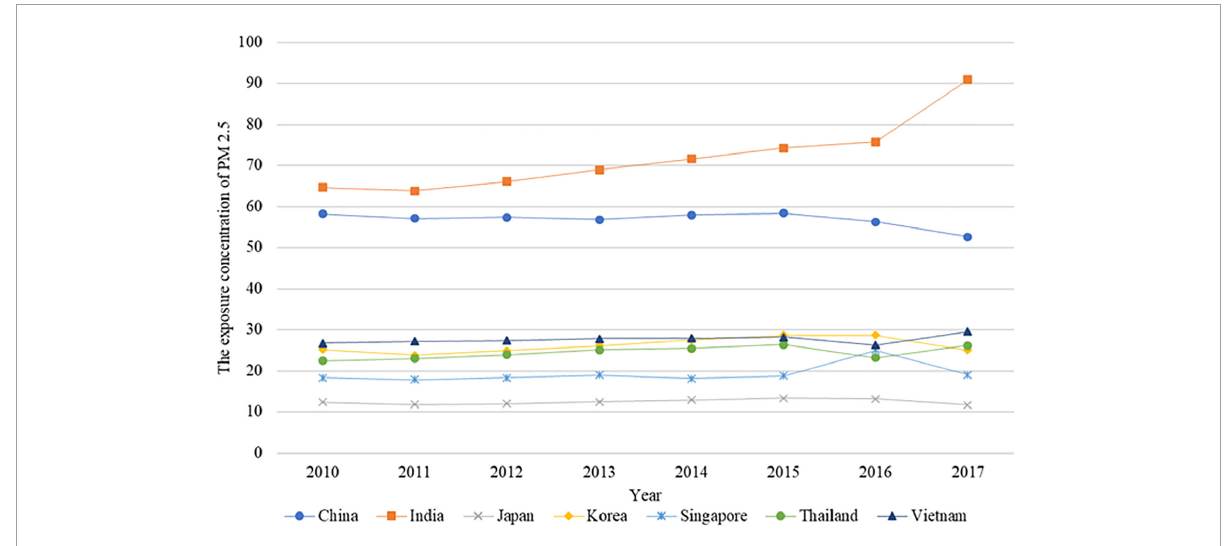
FIGURE1 The exposure concentration of PM 2.5 in different